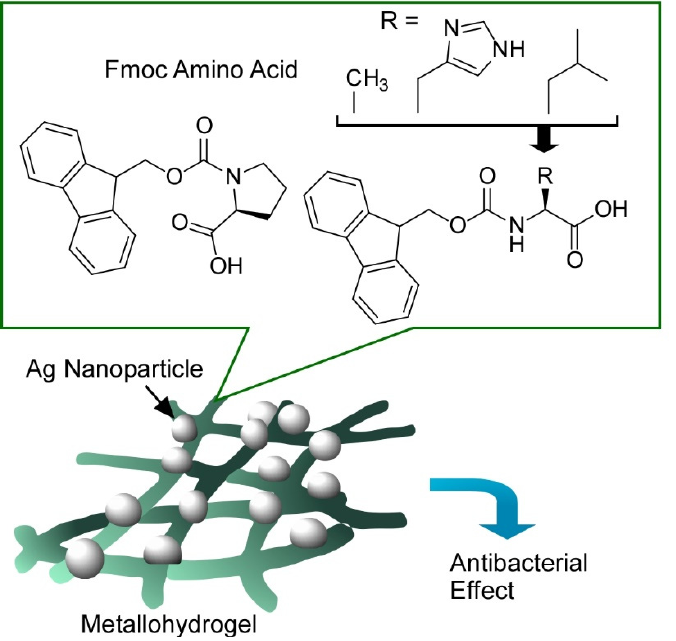
Figure 25. Metallohydrogels prepared from self-assembled nanofibers of Fmoc amino acids and Ag nanoparticles for antibacterial effects.